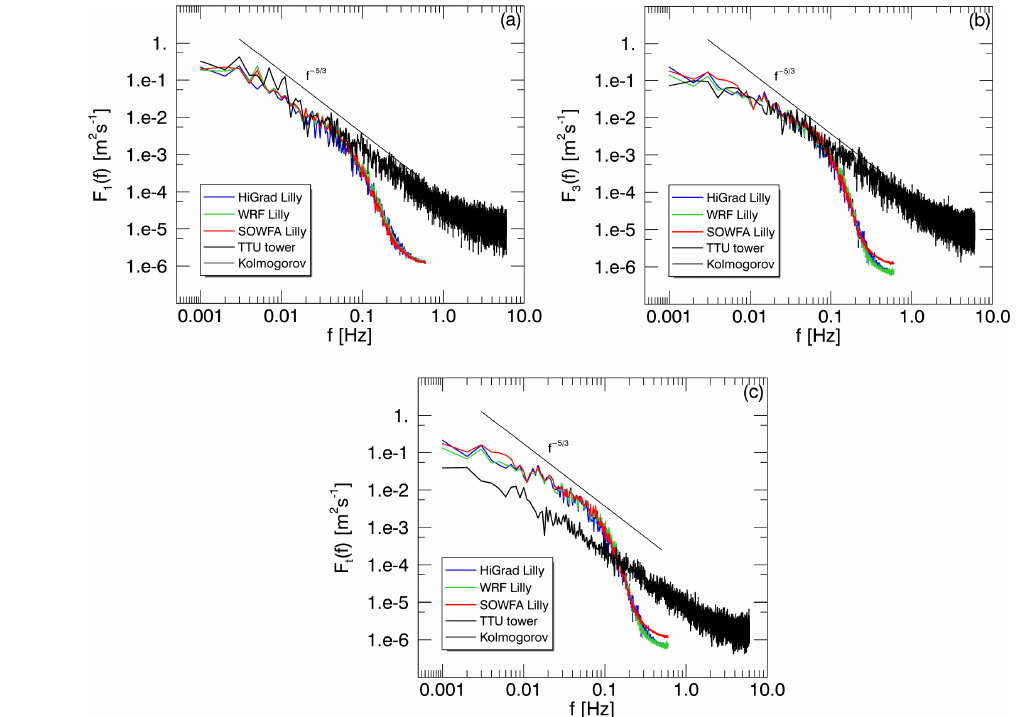
Figure 17. Simulated and measured spectra of streamwise velocity (a) , vertical velocity (b) , and measured virtual potential temperature versus simulated vertical potential temperature (c) from the convective case